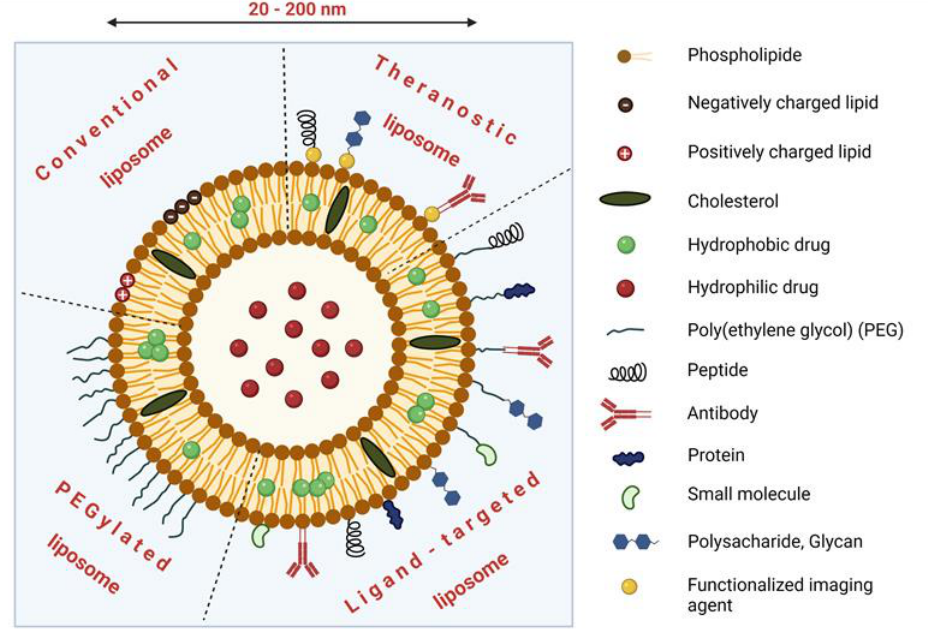
Figure 3. The structure of liposome-based nanocarriers. Created with BioRender 20 / 12 / 2021. Uptake of the drug inside the liposome contributes significantly to an increased ther- apeutic index of the loaded drugs, mainly due to (i) protection of the drug against enzy- matic degradation, immunologic and chemical inactivation; (ii) prevention of its metabo- lization before reaching target tissue; (iii) reduced drug exposure to healthy tissues; (iv) increased blood circulation half-life [67,68]. According to the number of their layers (also called lamellae), the liposomes can be divided into multilamellar ( ˃ 500 nm), small unila- mellar (20 – 100 nm), or large unilamellar vesicles ( ˃ 100 nm) [59]. In general, the lipids uti-